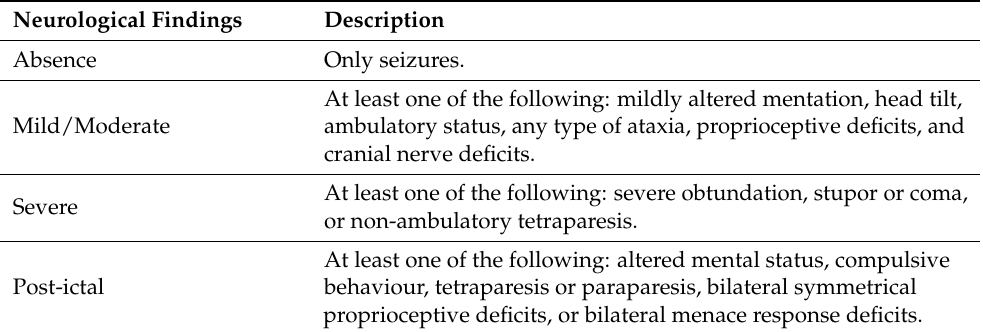
Table 1. Classification of neurological findings in 60 dogs with presumed brain